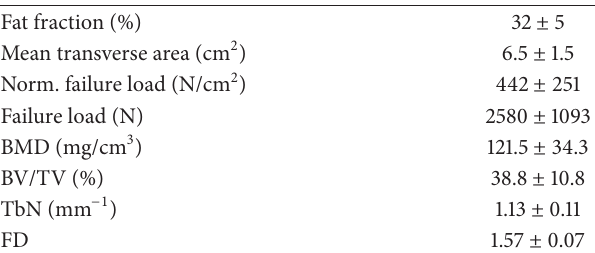
Table 1: Mean and SD values of experimental parameters measured with MRS (proton density fat fraction), biomechanical testing (failure load and normalized failure load), and MDCT (mean transversecross-sectionalarea,BMD,andtrabecularmicrostructure